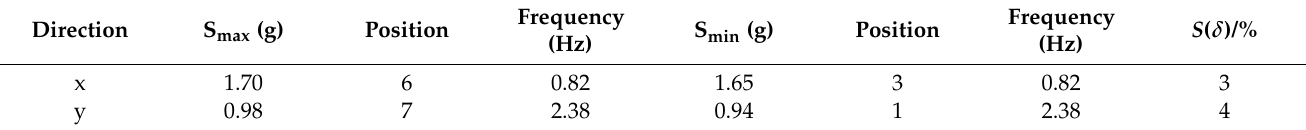
Table 6. Floor response spectrum at different positions of the raft foundation.